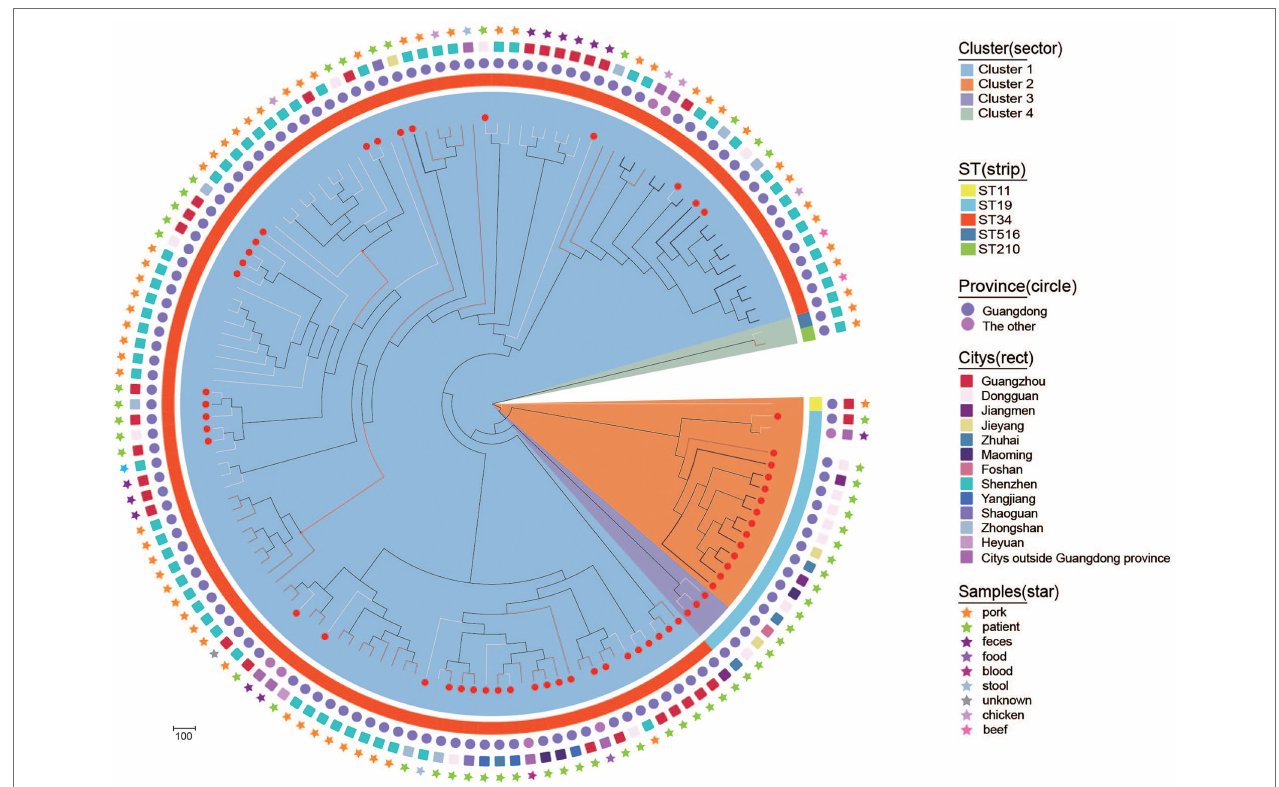
FIGURE 4 | Phylogenetic structures of the bla CTX-M -positive S. Typhimurium isolates from this study and the GenBank database. The Bayesian evolutionary tree shows the relationships among the 141 bla CTX-M-55/14/65 -positive S. Typhimurium isolates. Sample source, city, province and ST from which isolates obtained are indicated as star, rect, circle, and strip. bla CTX-M-55 -positive, bla CTX-M-14 -positive, and bla CTX-M-65 -positive S. Typhimurium are indicated with a white, black, and red line, respectively. The red dots on the branches represent the bacteria that belong to this